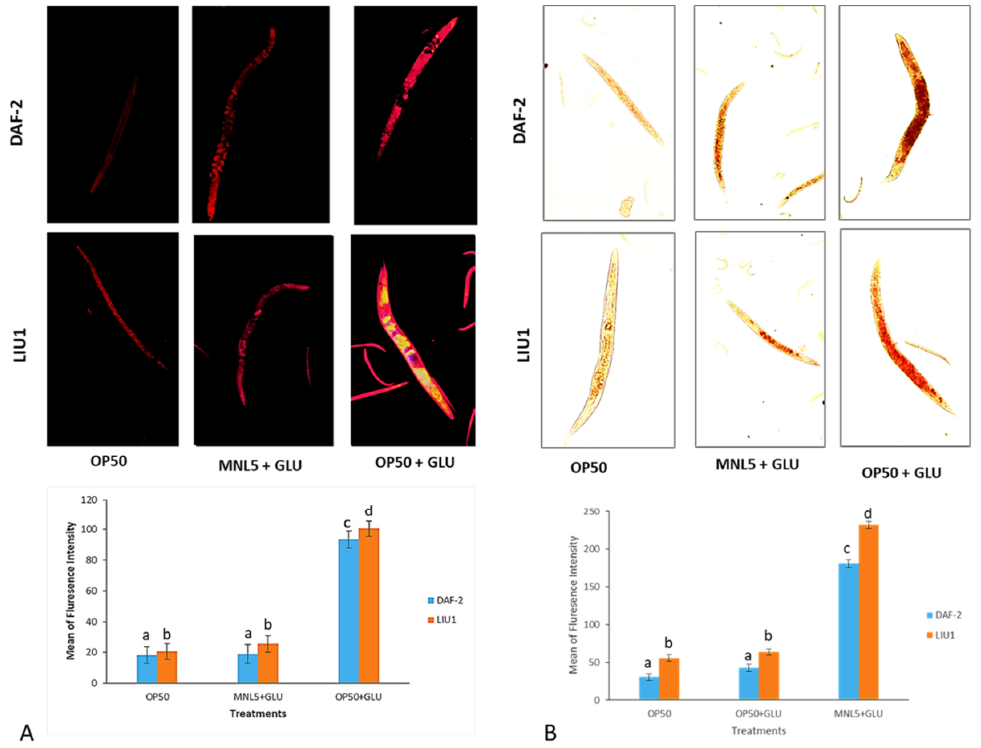
Figure 6. Lipid content visualized by C. elegans body (DAF-2 and LIU1 model) by fluorescence intensity measured by ImageJ software. Microscopic images showing different treatments such as OP50 (Control), MNL+ GLU ( P. acidilactici MNL5 with Glucose) [Treatment]), OP50+GLU ( E.coli OP50 with Glucose [Positive Control]; ( A ) Nile Red staining by fluorescence microscope (20× magnification); ( B ) Oil Red O staining by light microscope (20× magnification). Bar diagram presents the relative lipid content of worms. The error bar represents the mean ± SEM). Different superscripts ( a, b, c, d ) represent significantly different values ( p < 0.05).